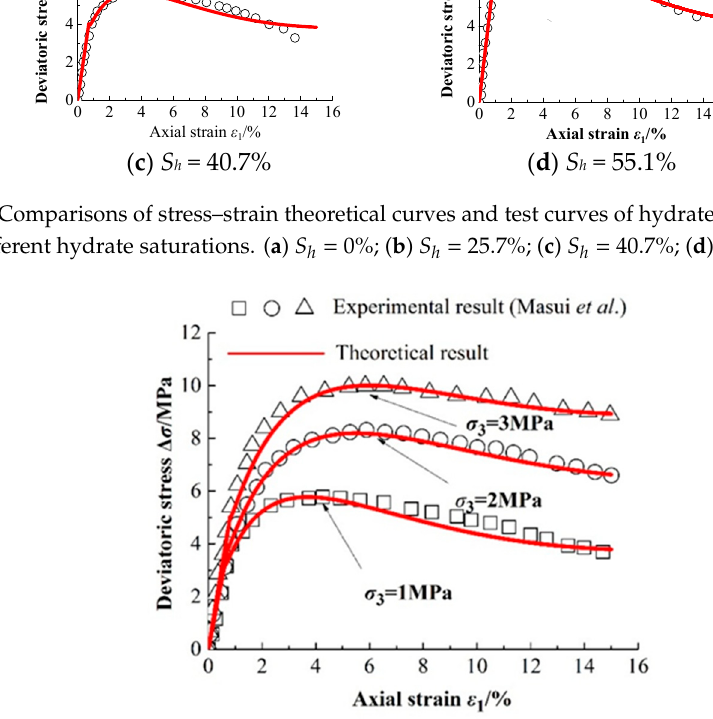
Figure 3. Comparison of stress–strain theoretical curves and test curves of hydrate-bearing sediments under different confining pressures.